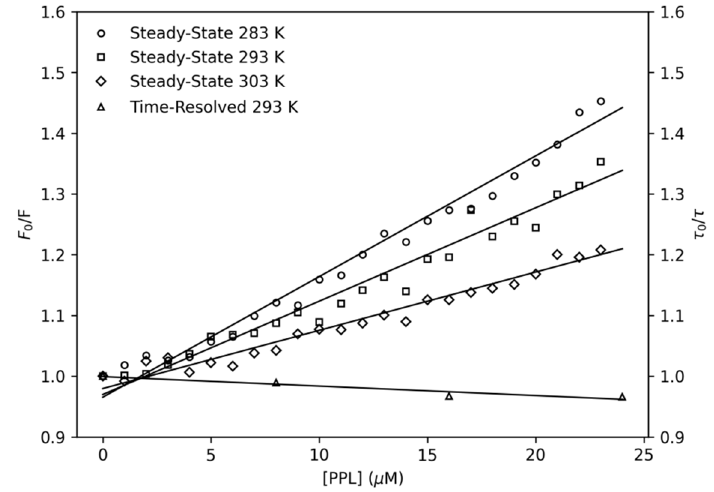
Figure 2. Left ordinate: Stern–Volmer plots at three temperatures, 283 K, 293 K, and 303 K. Right ordinate: Time-resolved fluorescence lifetime plot at 293 K; [ NBD ] = 4.0 μM, [ PPL ] = 0–24.0 μM. PPL was added to the sample in increments of 1.0 μM.